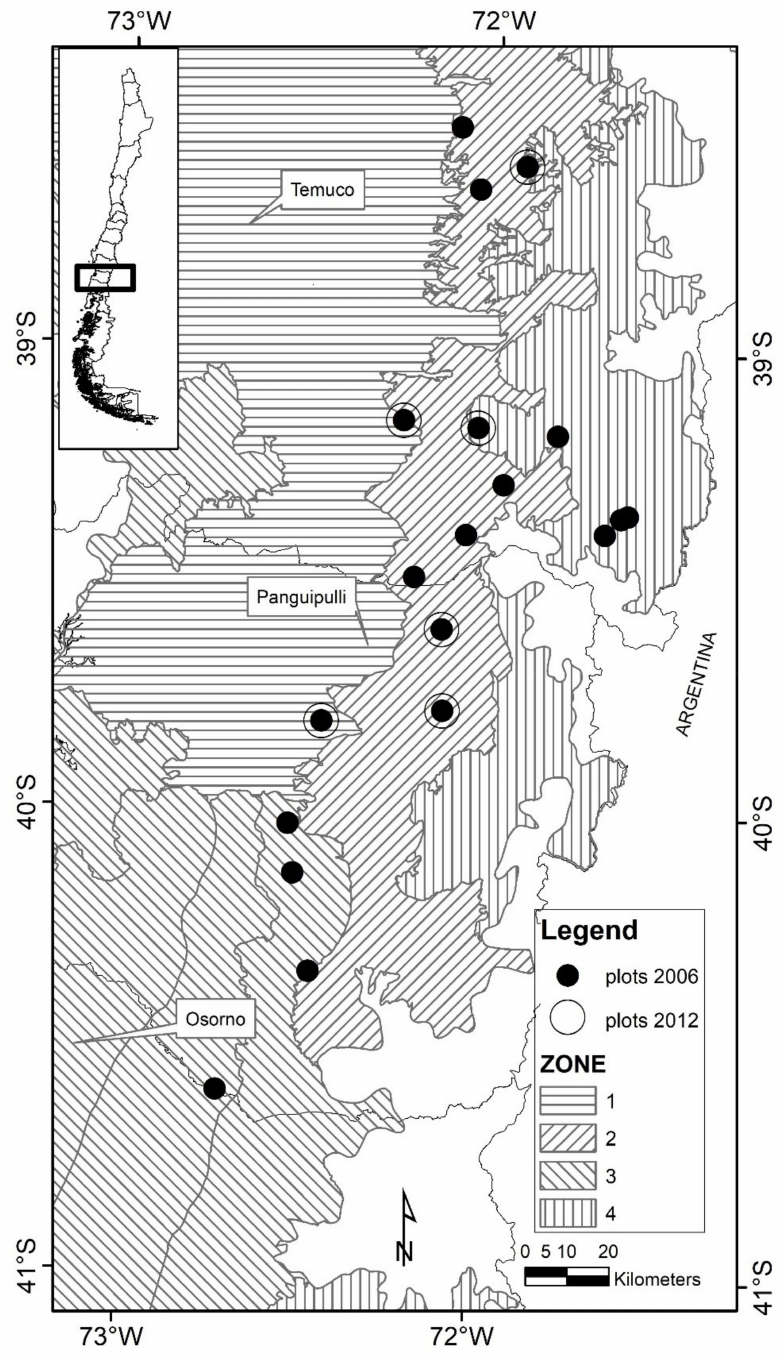
Figure 1. Geographical location of permanent plots in second-growth RORACO forests in southern Chile established in 2000, with a first remeasurement in 2006 ( n = 19) and a second in 2012 ( n = 6). Growth zones defined for RORACO forests also are